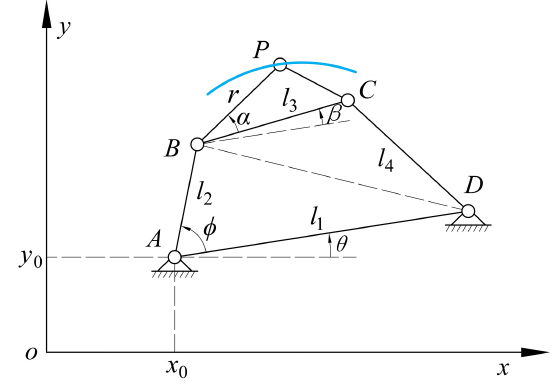
Figure 1. The planar four-bar mechanism and its